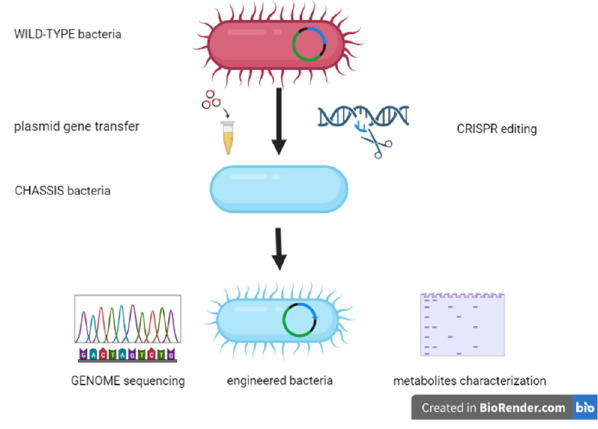
Figure 3. Engineering steps for a candidate chassis wild-type bacterium.